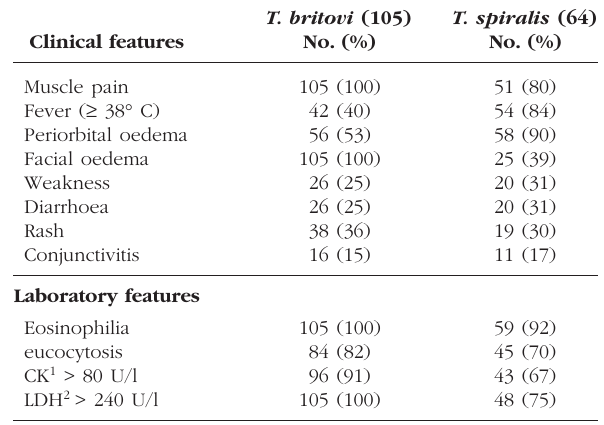
Table II. – Number and percentage of symptomatic people showing clinical and laboratory features, who attended the Clinic of Infec- tious, Parasitic and Tropical Medicine, Sofia, Bulgaria, in the period